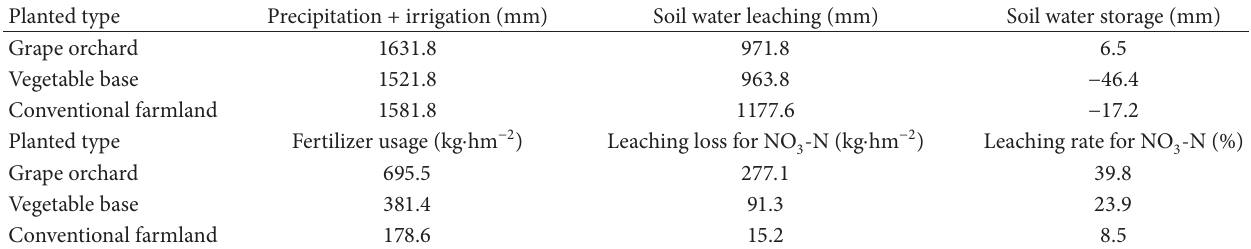
Table 3: Simulated soil water leaching and soil water storage variation under different planting systems.